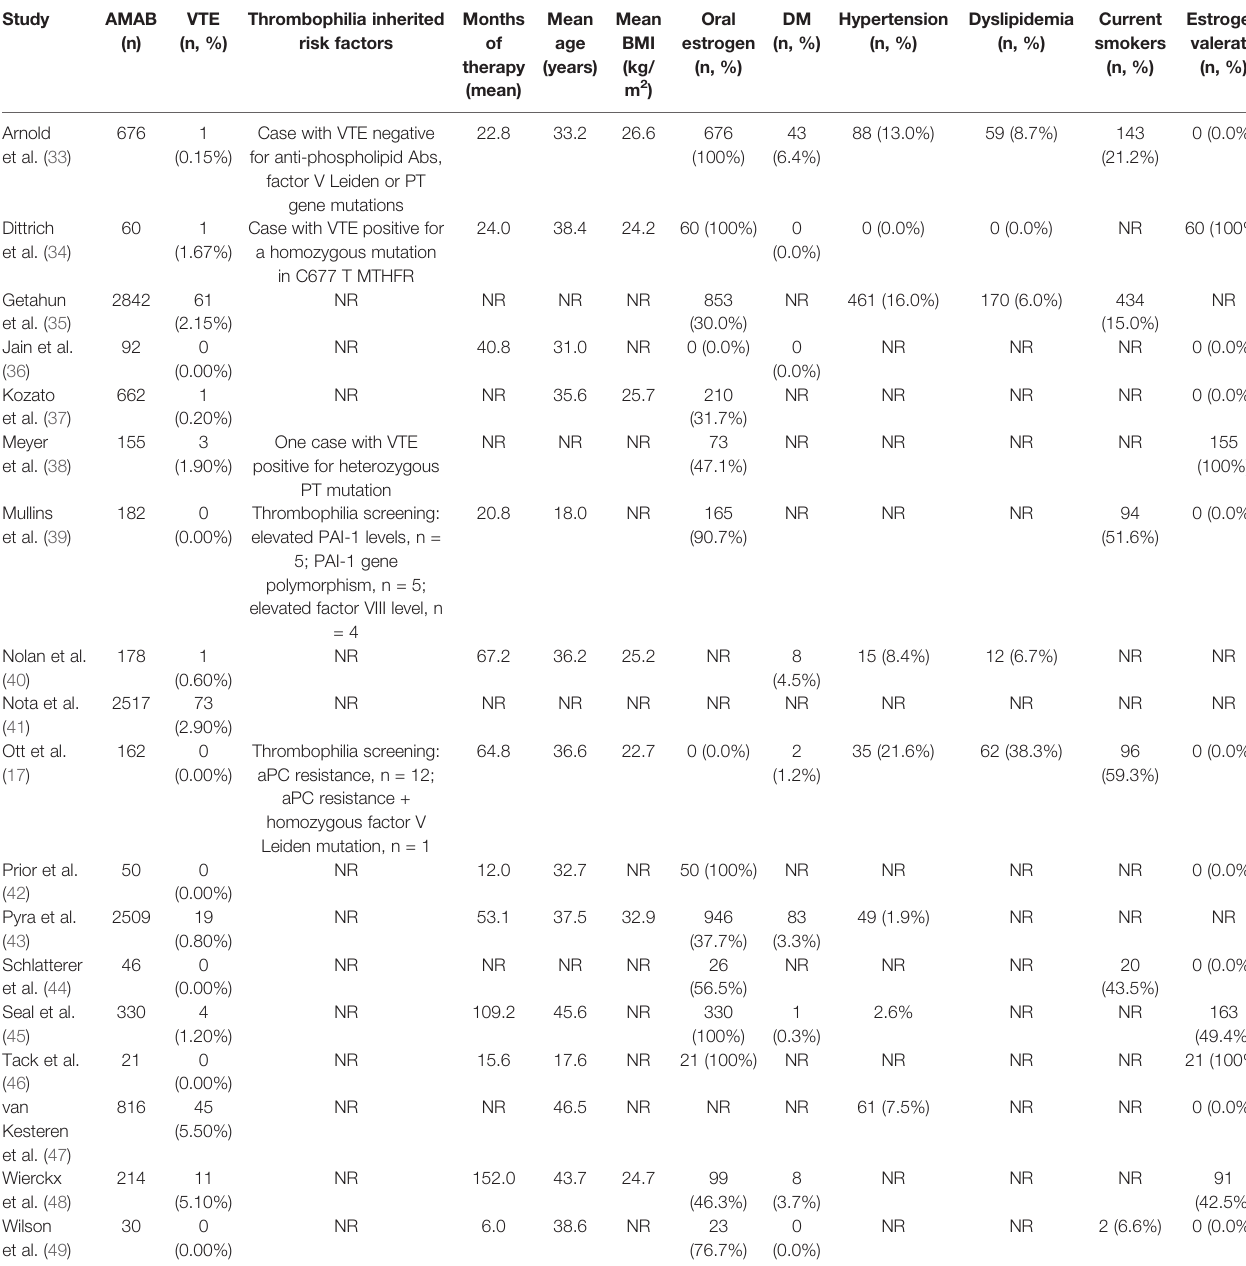
TABLE 1 | Characteristics of the included